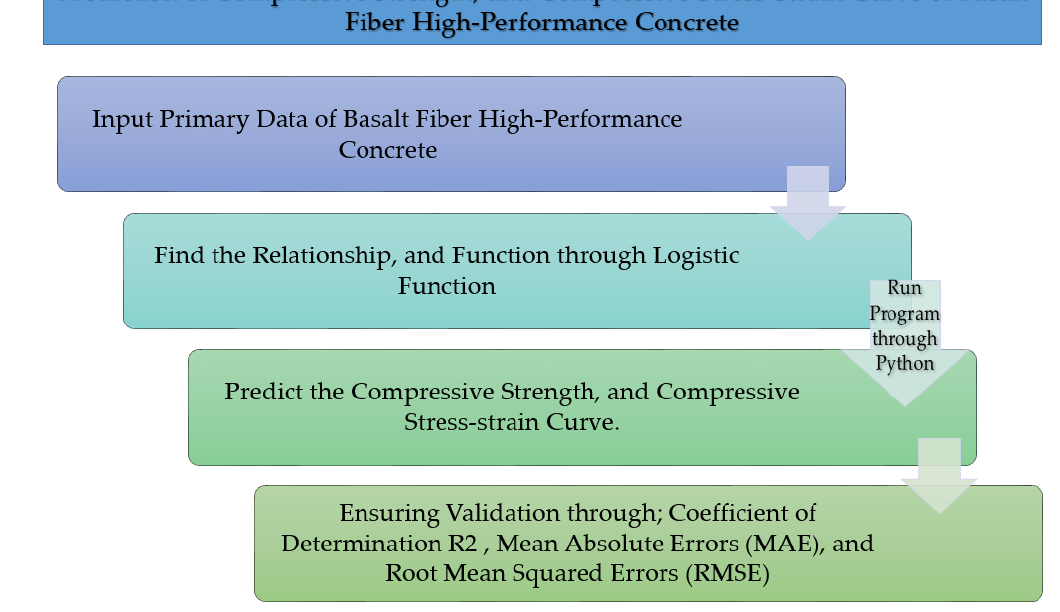
Figure 9. Prediction research methodology in this study.